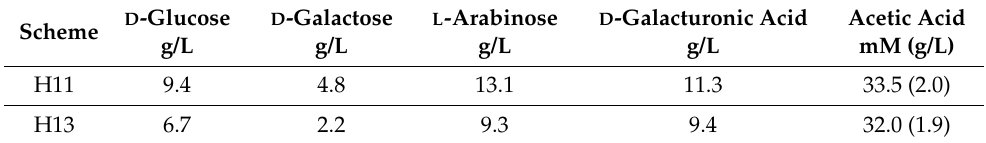
Table 1. Composition of the two sugar beet pulp (SBP) hydrolysate batches used in this study. D -Glucose D -Galactose L -Arabinose D -Galacturonic Scheme g/L g/L